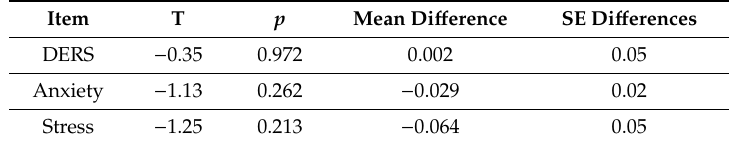
Table 2. t -test for equality (independent samples test) of means by study group (training vs control). Item T p Mean Di ff erence SE Di ff erences